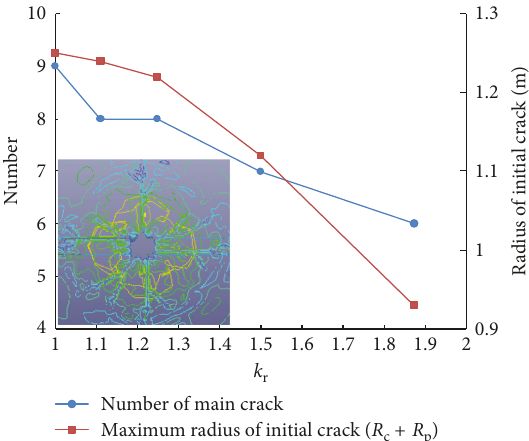
Figure 7: Effects of k r on the development of main cracks.